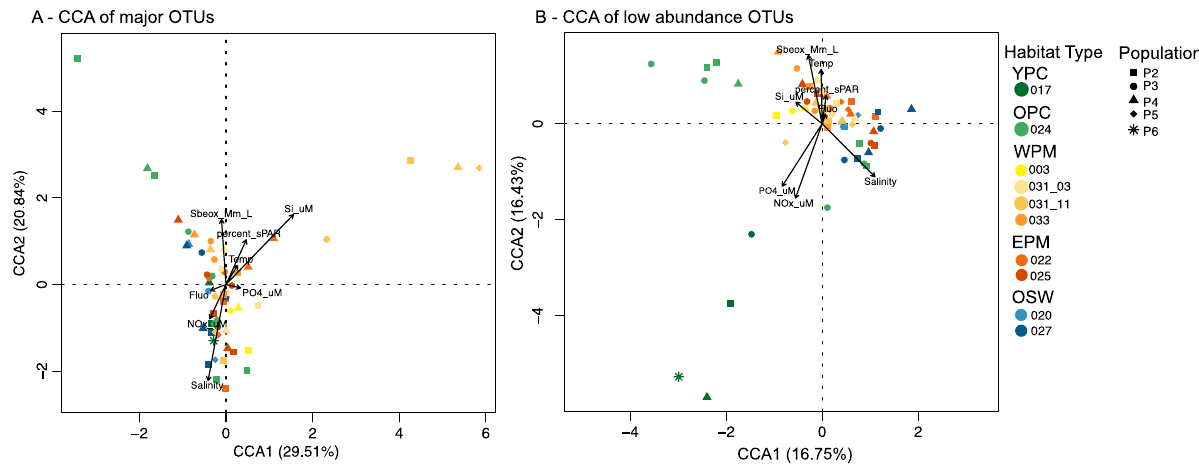
Figure 6. Canonical correspondence analysis with A major OTUs, and B low abundance